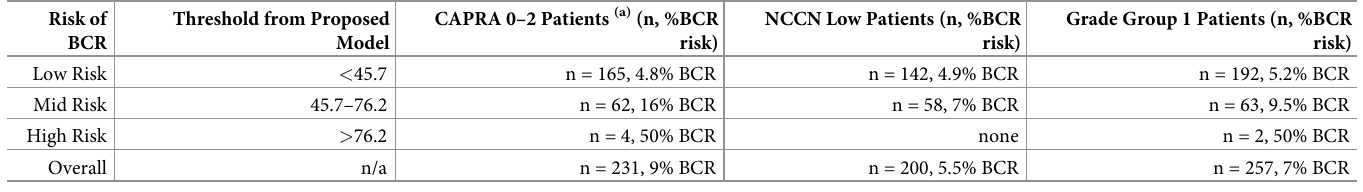
Table 3. Performance of the proposed model for biochemical free survival (BCR) in CAPRA 0–2, NCCN low and Grade Group 1 patient population.